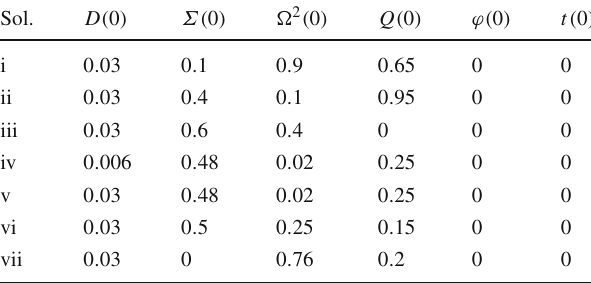
Table 3 Here we present seven initial data sets for the simulation of the full system (93) and time-averaged system (127) for the KS metric. All the conditions are chosen in order to fulfill the inequalities Σ 2 ( 0 ) + (cid:8) 2 ( 0 ) ≤ 1 and 0 ≤ Q ≤ 1